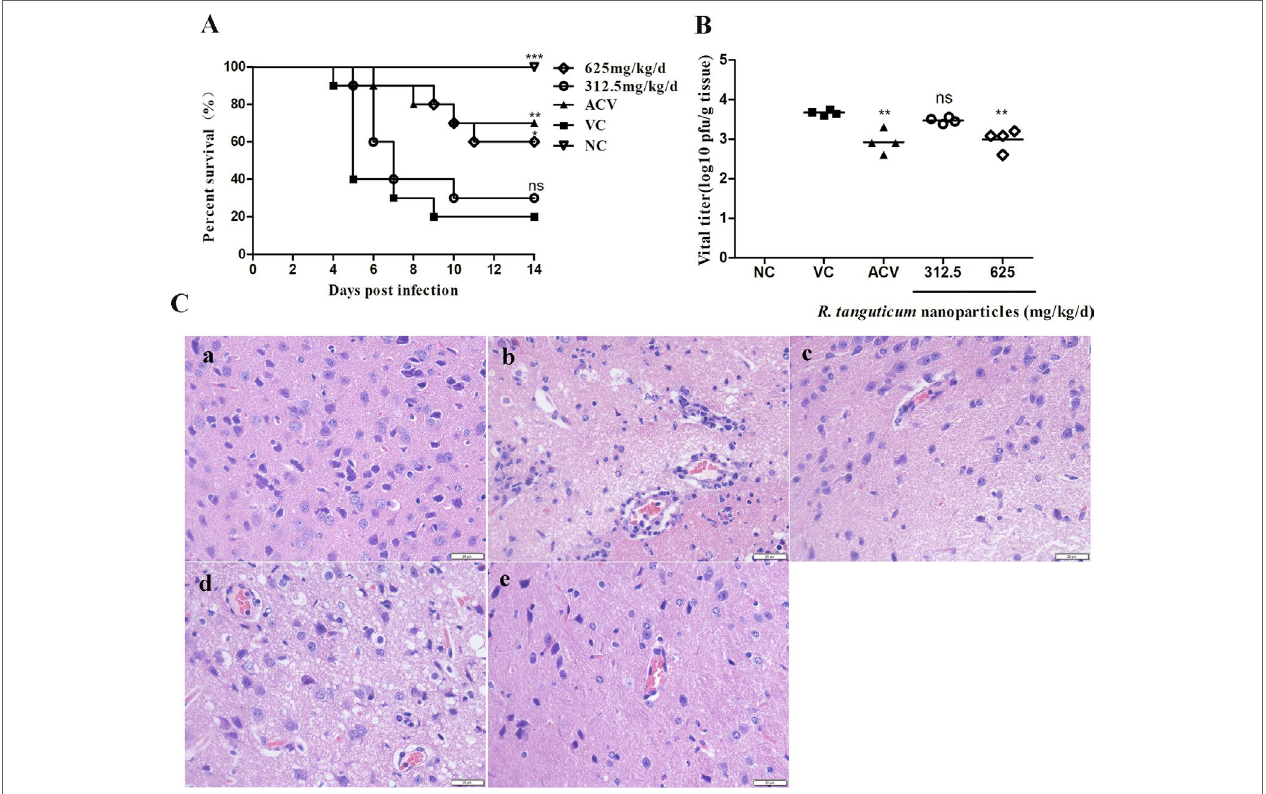
FIGURE 7 | R. tanguticum nanoparticles alleviated HSV-1 infection in mice. Kunming mice (n = 10 mice/group) infected with 5 LD 50 of HSV-1 were orally administered with 625 mg/kg/day and 312.5 mg/kg/day R. tanguticum nanoparticles, respectively. A 0.9% saline was used in viral control and normal control group. (A) The survival rates were collected daily for 14 day. (B) Brain Virus titers were determined by plaque assay at the 5th d.p.i. (C) Histological observations of cerebral tissues for mice sacrificed at the 5th d.p.i. Scale bar = 20 µm. (a) Mock infected mice treated with 0.9% saline (normal control, NC); (b) HSV-1-infected mice treated with 0.9% saline (viral control); (c) HSV-1-infected mice treated with acyclovir; (d–e) HSV-1-infected mice treated with 312.5 or 625 mg/kg/day of R. tanguticum nanoparticles.* p < 0.05; ** p < 0.01; *** p < 0.001; n.s., not significant.